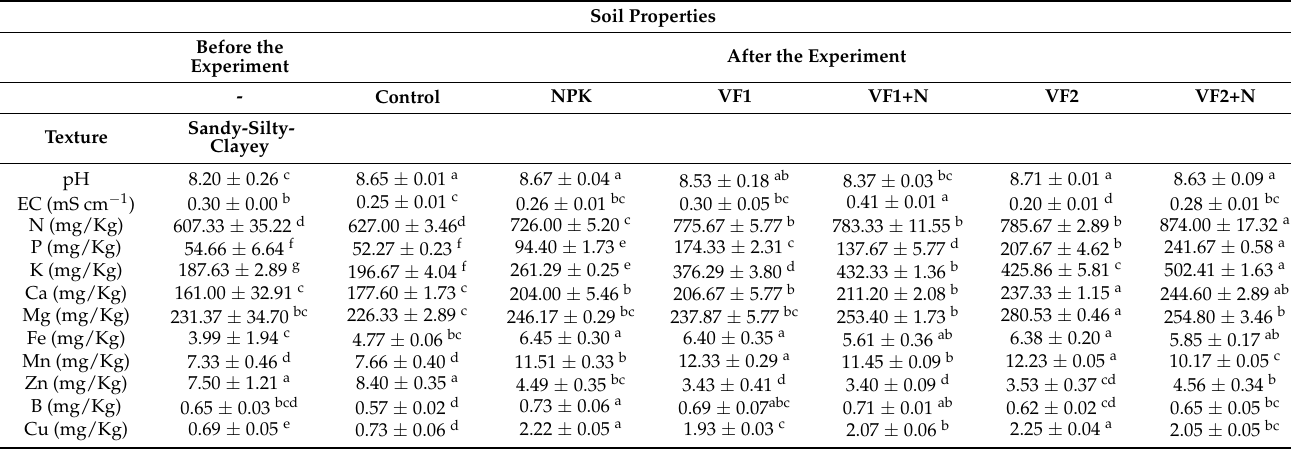
Table 6. Physicochemical analysis of soil before and after the cultivation of tomato and application of vitreous and chemical fertilizers in open